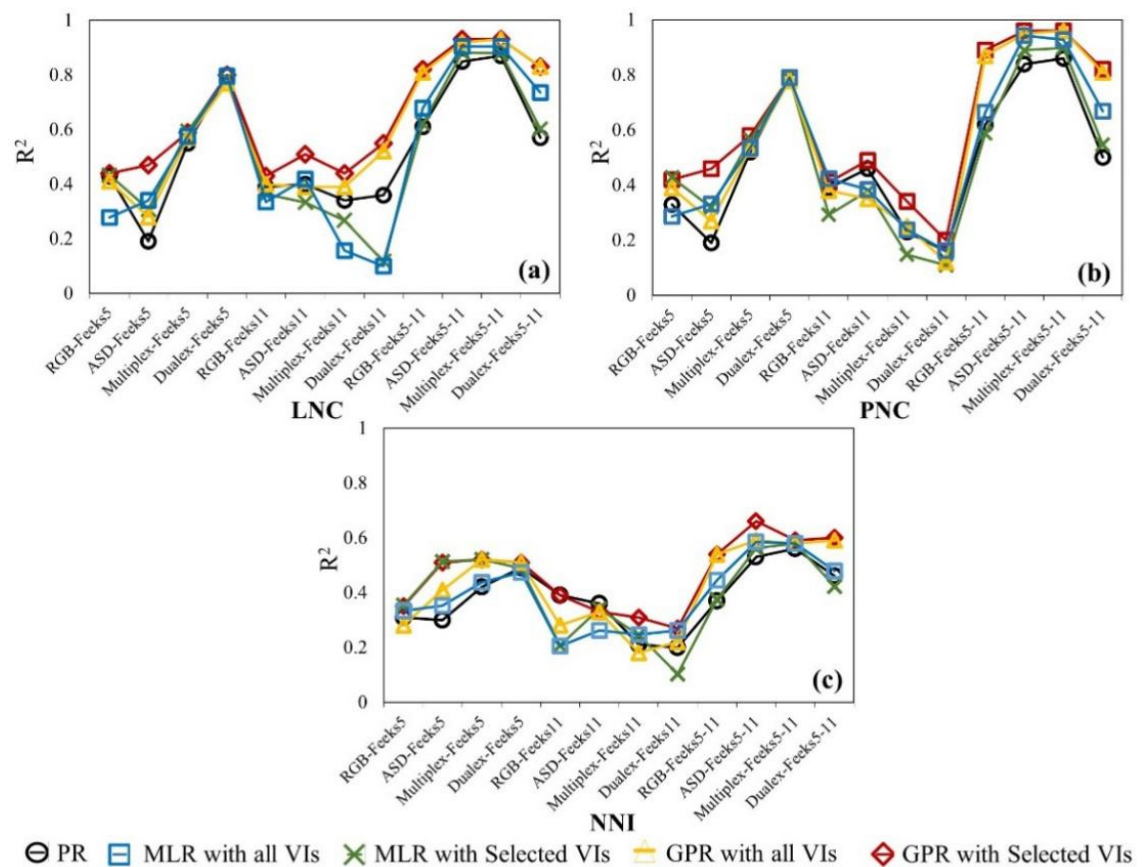
Figure 2. Cross-validation R 2 for LNC ( a ), PNC ( b ), and NNI ( c ) estimation with different sensors through PR, MLR, and GPR methods.